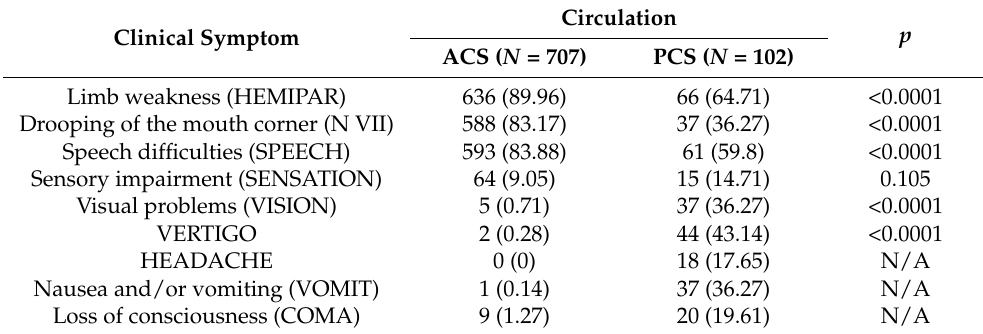
Table 2. Occurrence of presenting clinical symptoms in anterior circulation stroke (ACS) and posterior circulation stroke (PCS)